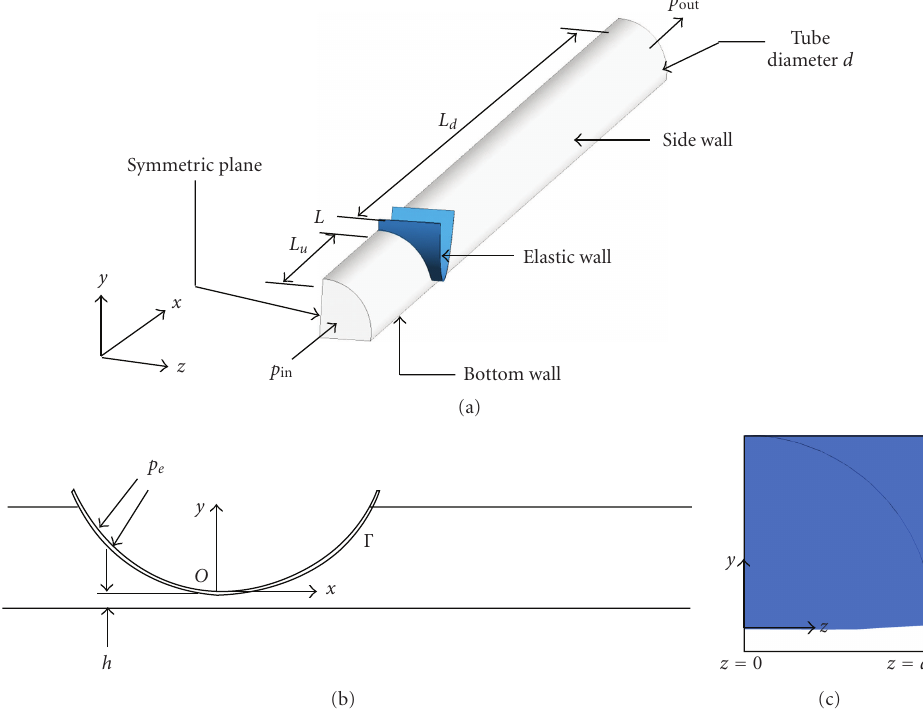
Figure 2: Model definition (a) isometric view, (b) side view looking at symmetrical plane, (c) frontal view looking from the